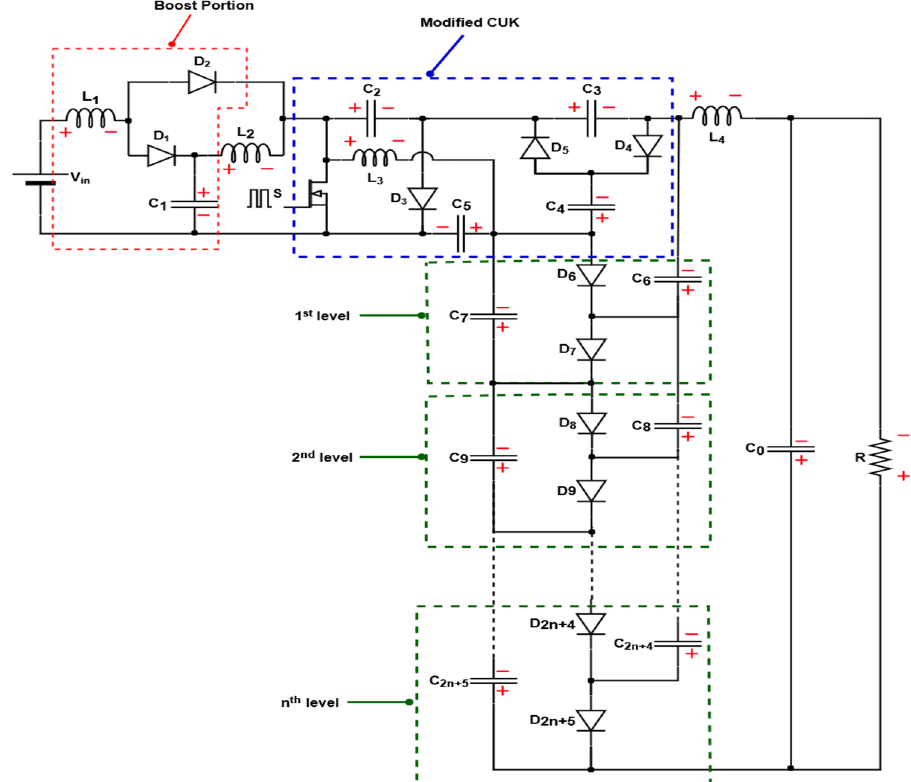
Figure 4. HGCC with n-level multiplier.